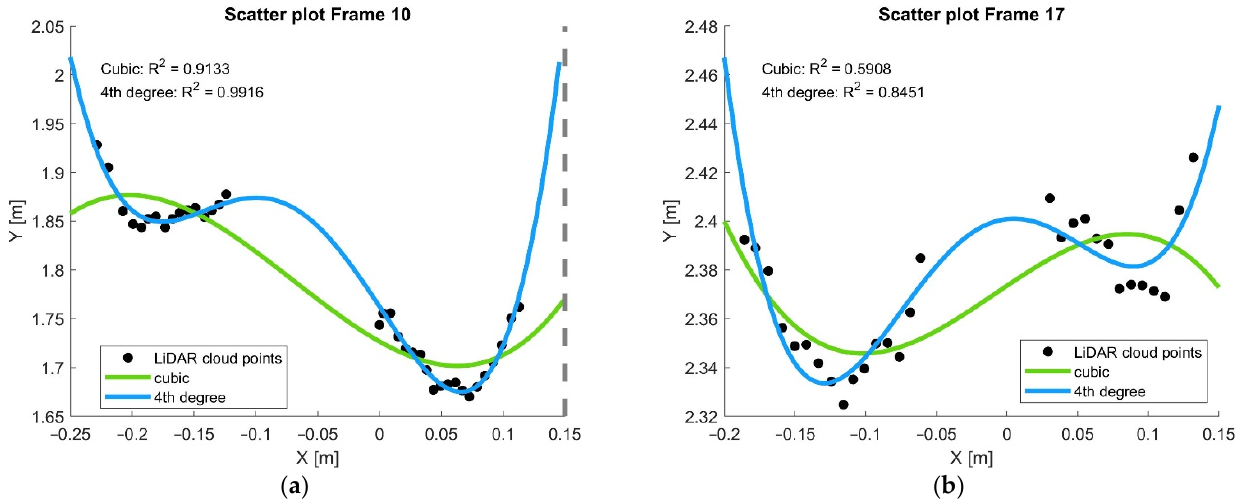
Figure 9. Scatter plot of the extracted cloud points, fitted with a quadratic polynomial of the 3rd degree and 4th degree, and the estimated heel position: ( a ) extracted calculated data from Frame 10; ( b ) extracted calculated data from Frame 17.